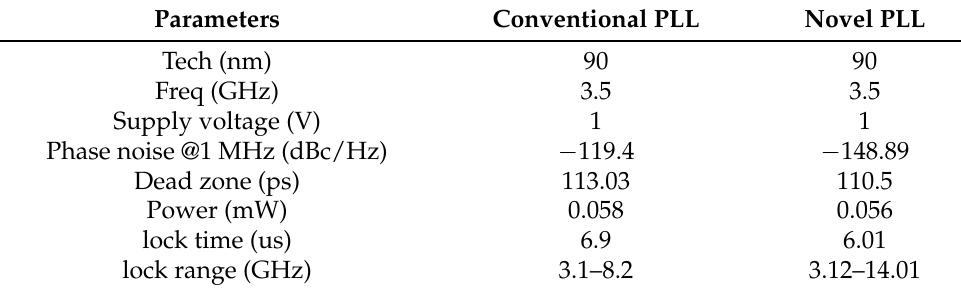
Figure 5. The control voltages of conventional and proposed PLLs. Table 1. Comparision of traditional PLL and novel CP-PLL